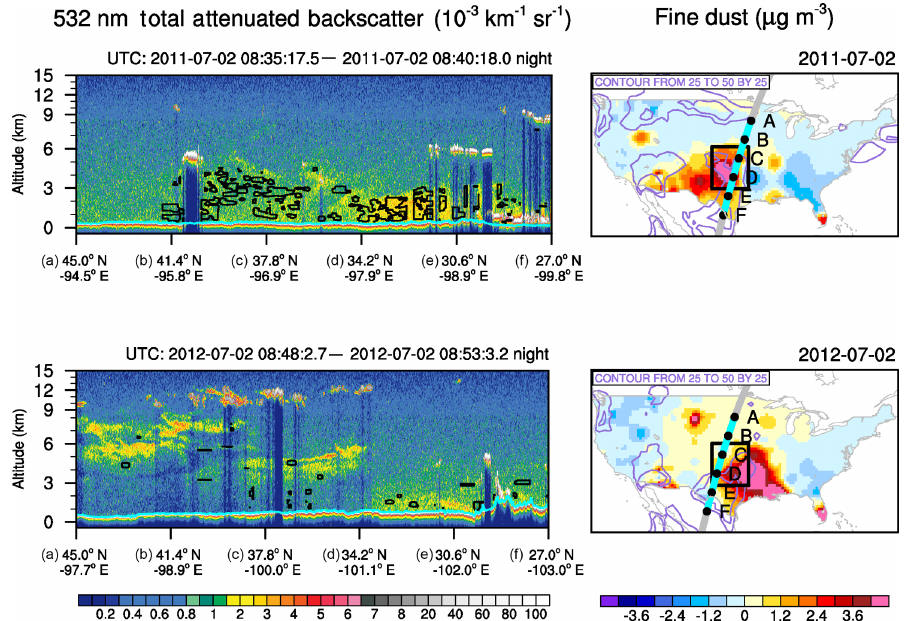
Figure 8. Same as Fig. 7 but for 2 July 2011 (top) and 2 July 2012 (bottom). Only positive CIN anomalies from 25 to 50Jkg − 1 are shown (light purple